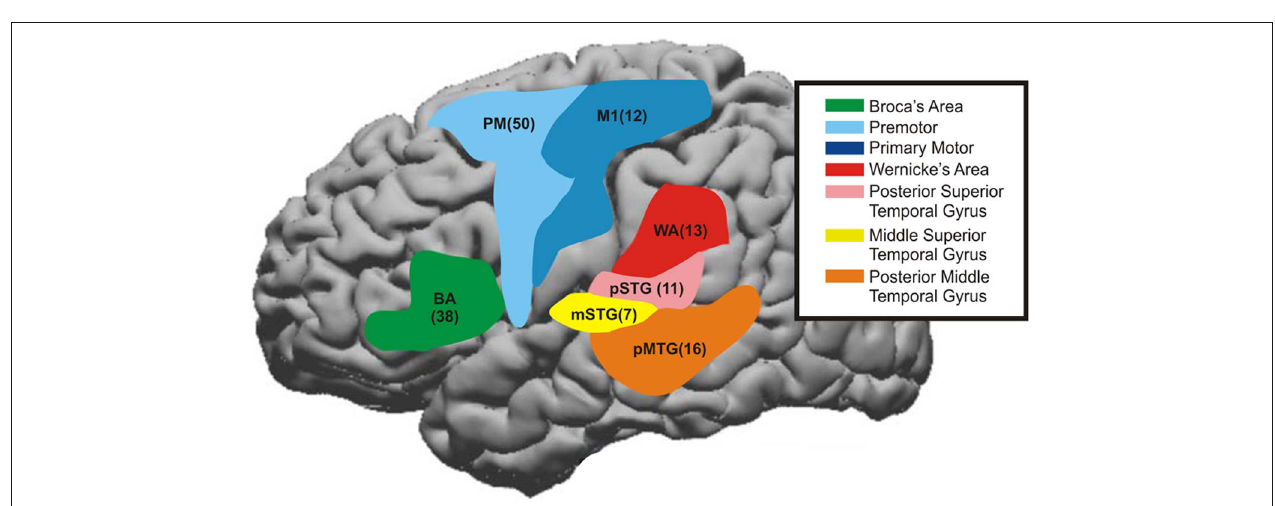
corresponding locations indicated by symbols in the brain on the left. Arrows mark the onset of the subject’s response. Activations are mostly focused on the gamma band.